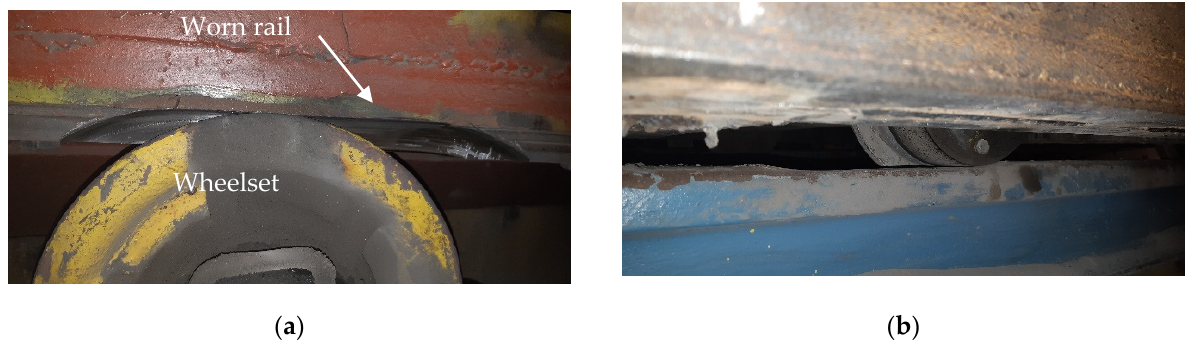
Figure 6. Example of the wear on the wheelset: ( a ) abrasive wear on the running rail in contact with the wheelset, ( b ) material loss in the running rail.